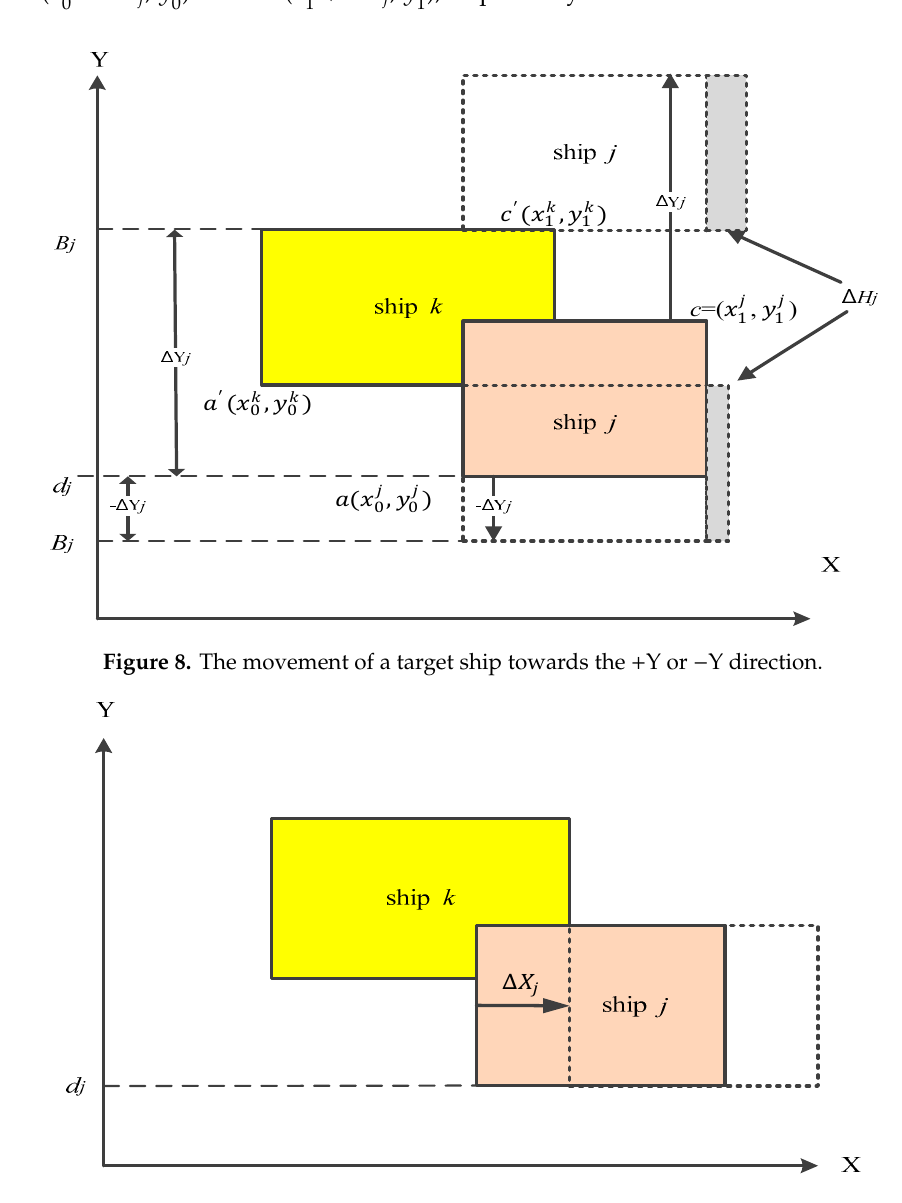
Figure 9. The movement of a target ship toward the +X direction .